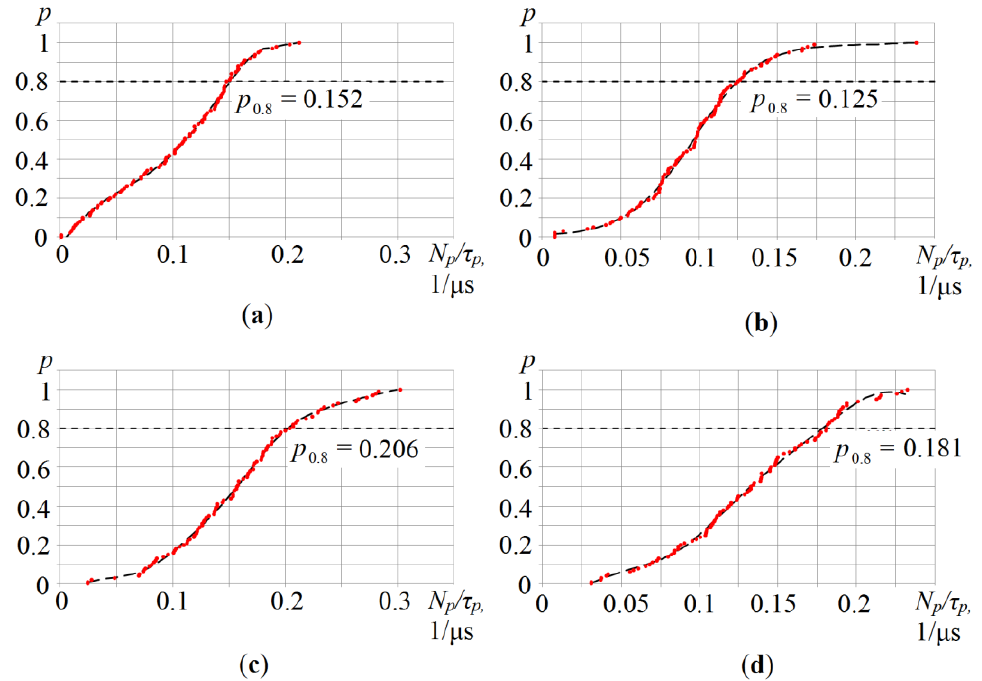
Figure 8. Comparison of the empirical distribution functions of the mean count frequency ( N p / τ p ) recorded during loading of steel specimens with a thickness of t = 1 mm ( a , b ) and t = 6 mm ( c , d ) in the moments when crack length reaches l = 1.7 mm ( a , c ) and l = 9.5 mm ( b , d ). When crack size was about l = 9.5 mm (Figure 8b,d), the ( N p / τ p ) p = 0.8 parameter also grew to the mean values of ( N p / τ p ) p = 0.8 = 0.206 [1/ µ s] for a 1 mm thick specimen and ( N p / τ p ) p = 0.8 = 0.181 [1/ µ s] for 6 mm thick specimen. The difference between the maximum and minimum values of the ( N p / τ p ) p = 0.8 parameter were ∆ ( N p / τ p ) = 0.054 [1/ µ s] for 1-mm specimen and ∆ ( N p / τ p ) = 0.056 [1/ µ s] for 6-mm specimen. The relative change in the difference between the mean count frequency of AE signal for specimens with 1 mm and 6 mm thickness is 3.6%.